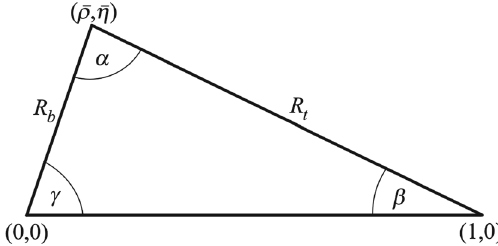
Fig. 1 The unitarity triangle